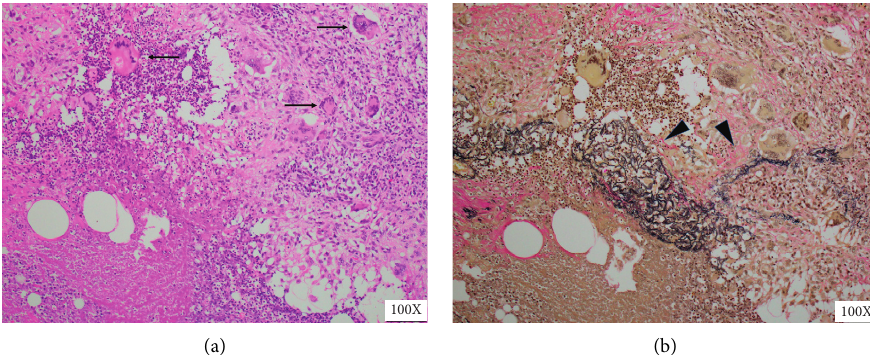
Figure 4: Histopathological findings of the biopsy of the nodule in the right breast. Lymphocyte-dominant inflammatory cell infiltration and granulomas with polynuclear giant cells (arrow) are visible around the blood vessels in the subcutaneous fat layer with hematoxylin and eosin staining (a). Verhoeff’s Van Gieson staining shows destruction of the elastic plate (b)